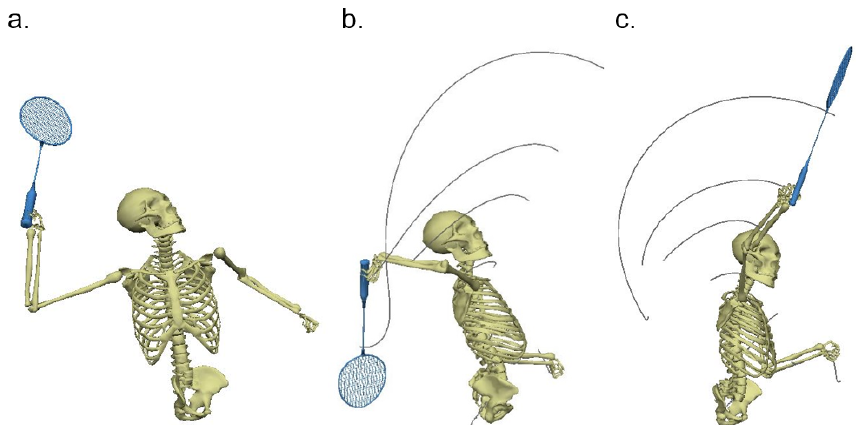
Figure 1. A representation of the normalised swing phase instants for one typical participant; ( a ). start of swing (5 m/s); ( b ) end of backswing, and ( c ). racket–shuttle contact.